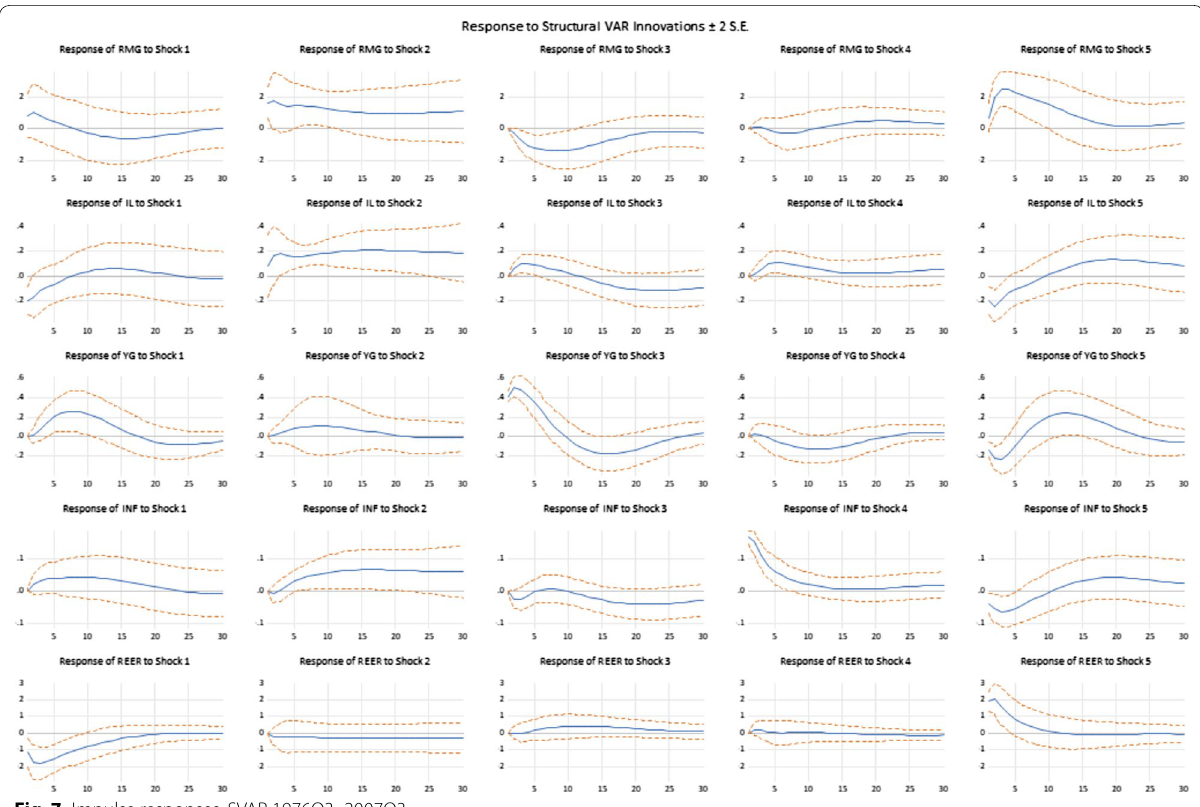
Fig. 7 Impulse responses, SVAR